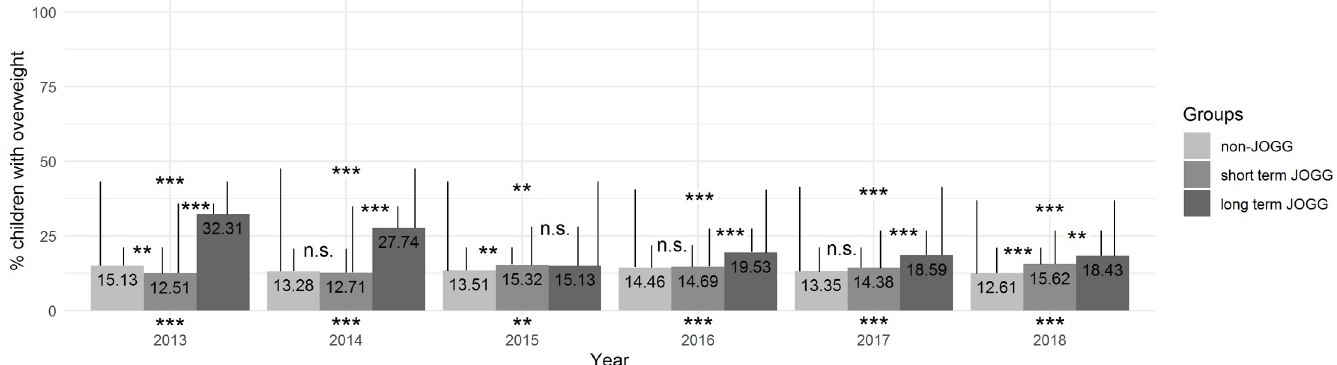
Fig 3. Prevalence of overweight in long-term JOGG areas, short-term JOGG areas and non-JOGG areas. Visual representation of overweight prevalence among children in non-JOGG areas, short-term JOGG areas, and long-term JOGG areas between 2013–2018. The statistical significance of the difference between the three groups is expressed below the bars; the results of post-hoc analyses are visualized in the Figure. � p < .05; �� p < .01; ��� p < .001.